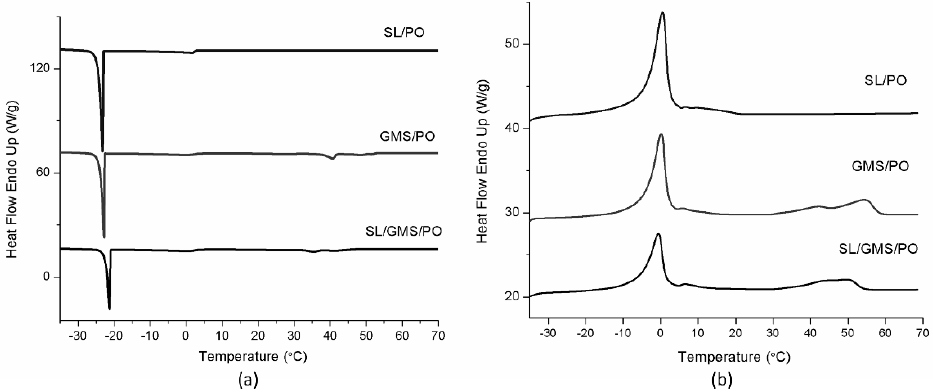
Figure 8. ( a ) DSC crystallization thermogram and ( b ) DSC melting thermogram of SL/PO, GMS/PO and SL/GMS/PO organogels.